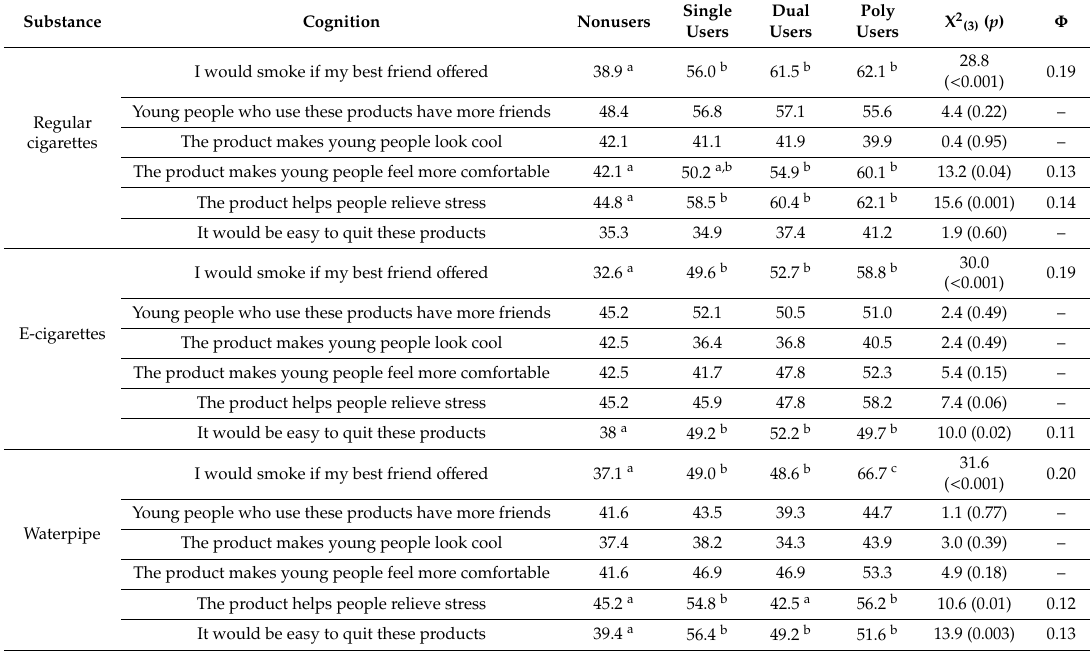
Table 1. Cognitions (percentage of answers “probably yes” or “definitely yes”) by polytobacco status. Substance